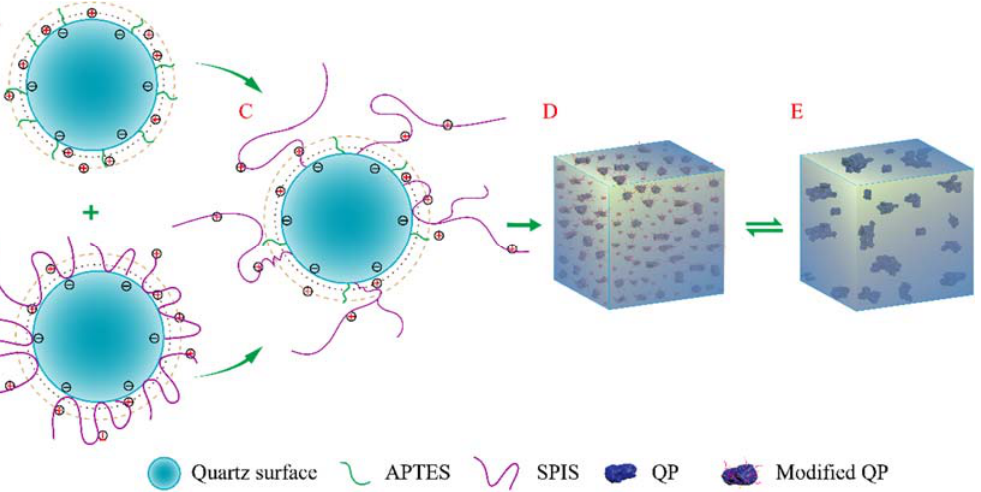
Figure 10. Schematic showing the performance improvement mechanism of the QP–EP composites. ( A ) QP modified by APTES. ( B ) QP modified by SPIS. ( C ) QP modified by dual SCAs. ( D ) EP composites with dual SCAs modified QP. ( E ) EP composites with pristine QP.